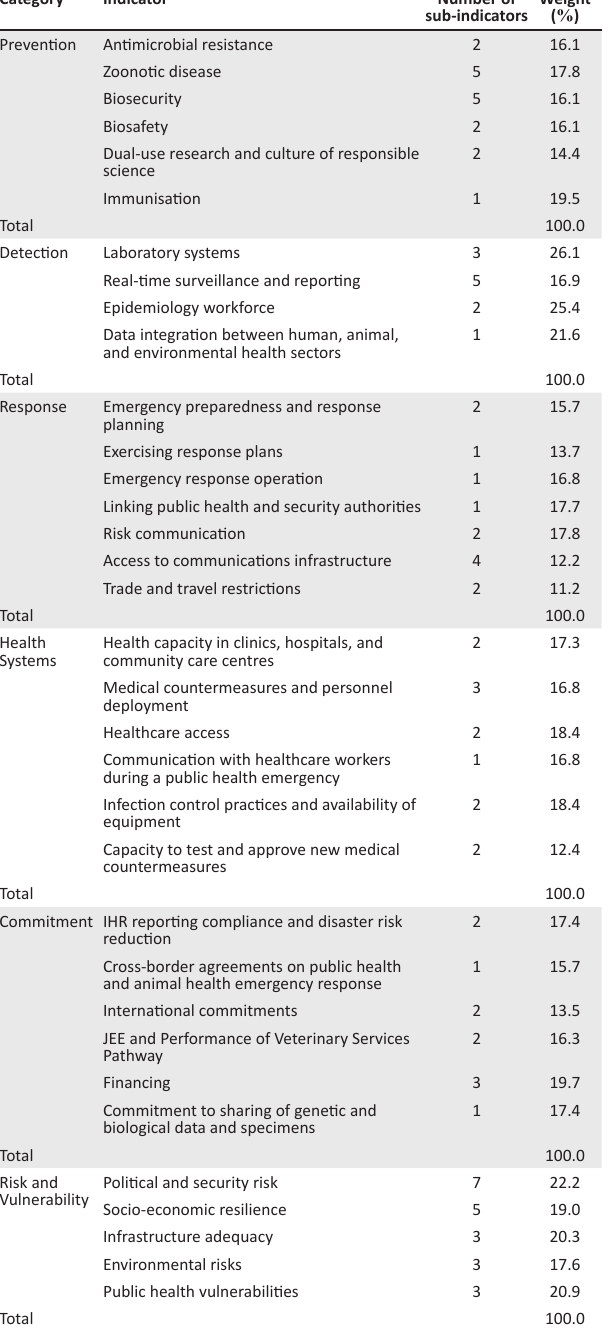
TABLE 2: Categories, indicators, and sub-indicators of the GHS Index.